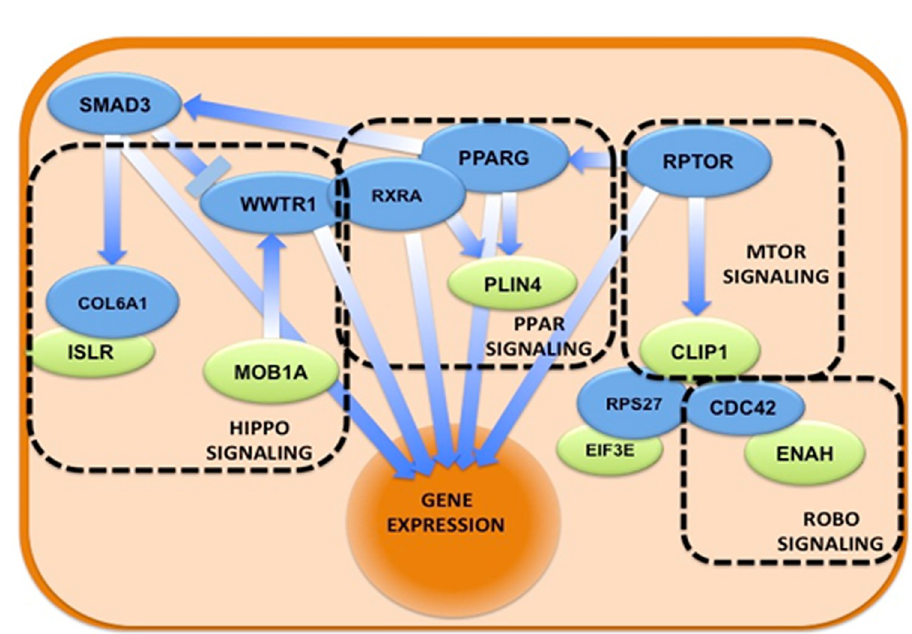
Fig 6. The biological network obtained using linker nodes for stage 2 breast cancer samples. Schematic representation of the molecular pathways in which the proteins of the set participate. Green ellipses represent proteins, while blue ellipses represent proteins that link all the input proteins. Overlapping proteins suggest physical interactions, while arrows indicate direct regulation. In dashed rectangles the different biological pathways that Reactome-FI detects as overrepresented in the full. The nucleus is represented as a wide orange ellipse because several pathways end with the effect on gene expression.